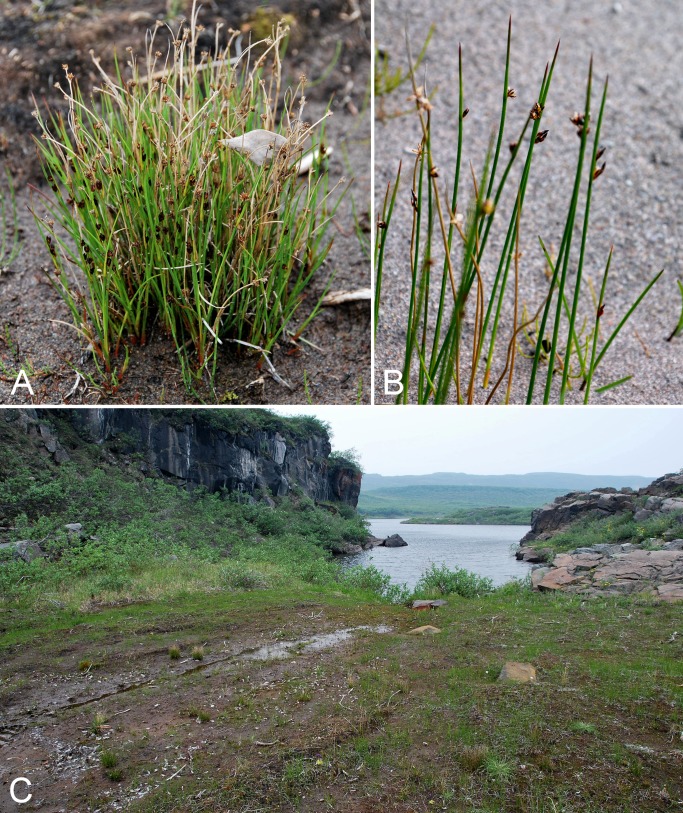
Juncus alpinoarticulatus subsp. americanus and Juncus arcticus subsp. alaskanus.Juncus alpinoarticulatus subsp. americanus: (A) habit, Saarela et al. 3858. (C) habitat, Saarela et al. 3858. Juncus arcticus subsp. alaskanus: (B) inflorescence, Saarela et al. 3720. Photographs by J. M. Saarela (A, C) and P. C. Sokoloff (B).